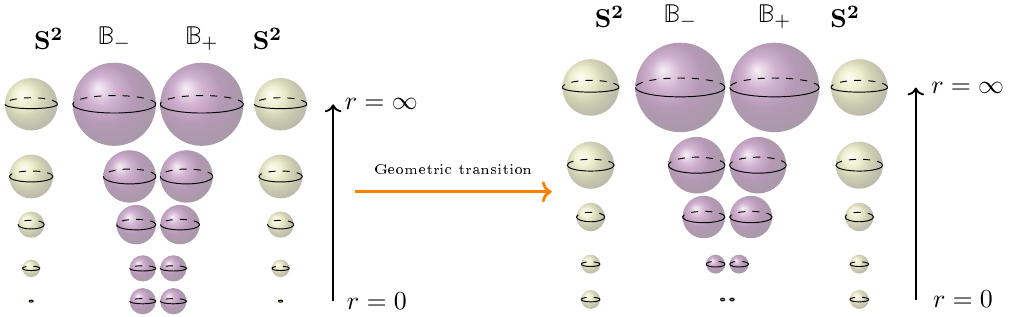
Figure 9 . The geometric transition between the deformed and resolved conifolds seen from the perspective 3-manifold surgery. We identify on the left the uplift of the surgical decomposition of S 3 (cid:26) T (cid:3) S 3 . Following this through the geometric transition brings us to the right (cid:12)gure which will be our starting point for de(cid:12)ning the closed string Hilbert space. While the S 2 is non-trivially (cid:12)bered over the S 3 in the deformed and resolved conifolds, for ease of illustration and discussion, we will indicate it as if it were a direct product; see footnote 8. Note that we have swapped the direction of the radial coordinate of the cone relative to (cid:12)gure 1 for ease of illustration. a codimension-1 Cauchy slice (cid:0) (which w.l.o.g. we think of as the t = 0 slice). As in